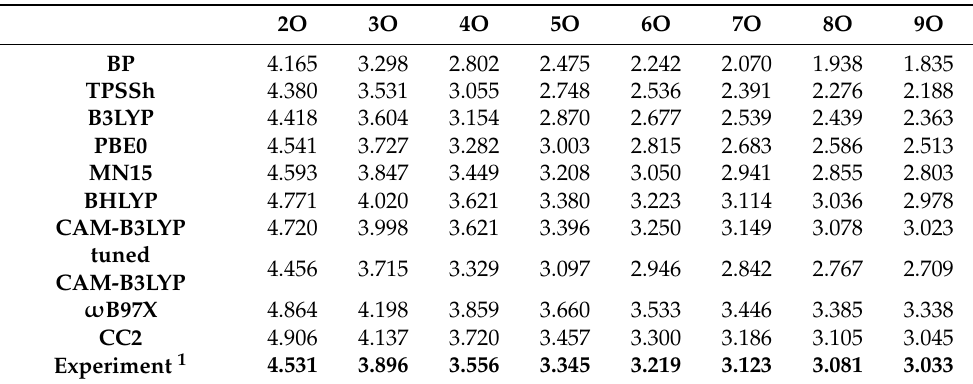
Table 1. Vertical absorption energies calculated for the studied oligofurans using the selected variants of DFT/TDDFT and the CC2 method with the def2-TZVPP basis set.